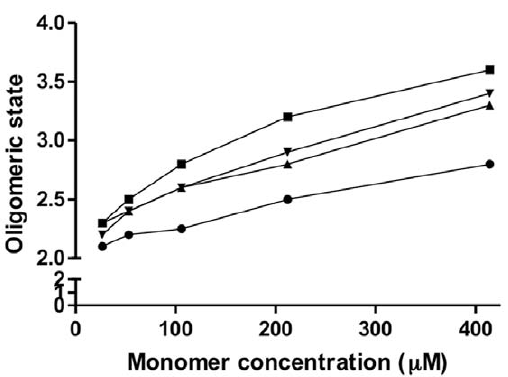
Figure 6. Influence of deletions in the a - helical linker on the oligomerisation state of the PAS1 domain in the 1–162 construct. The concentration dependence of the association state as assessed by SEC is plotted for: NifL (1–162) (circles); NifL (1–162) D L151 (upward triangles); NifL (1–162) D R150-L151 (downward triangles) and NifL (1–162) D N147-L151